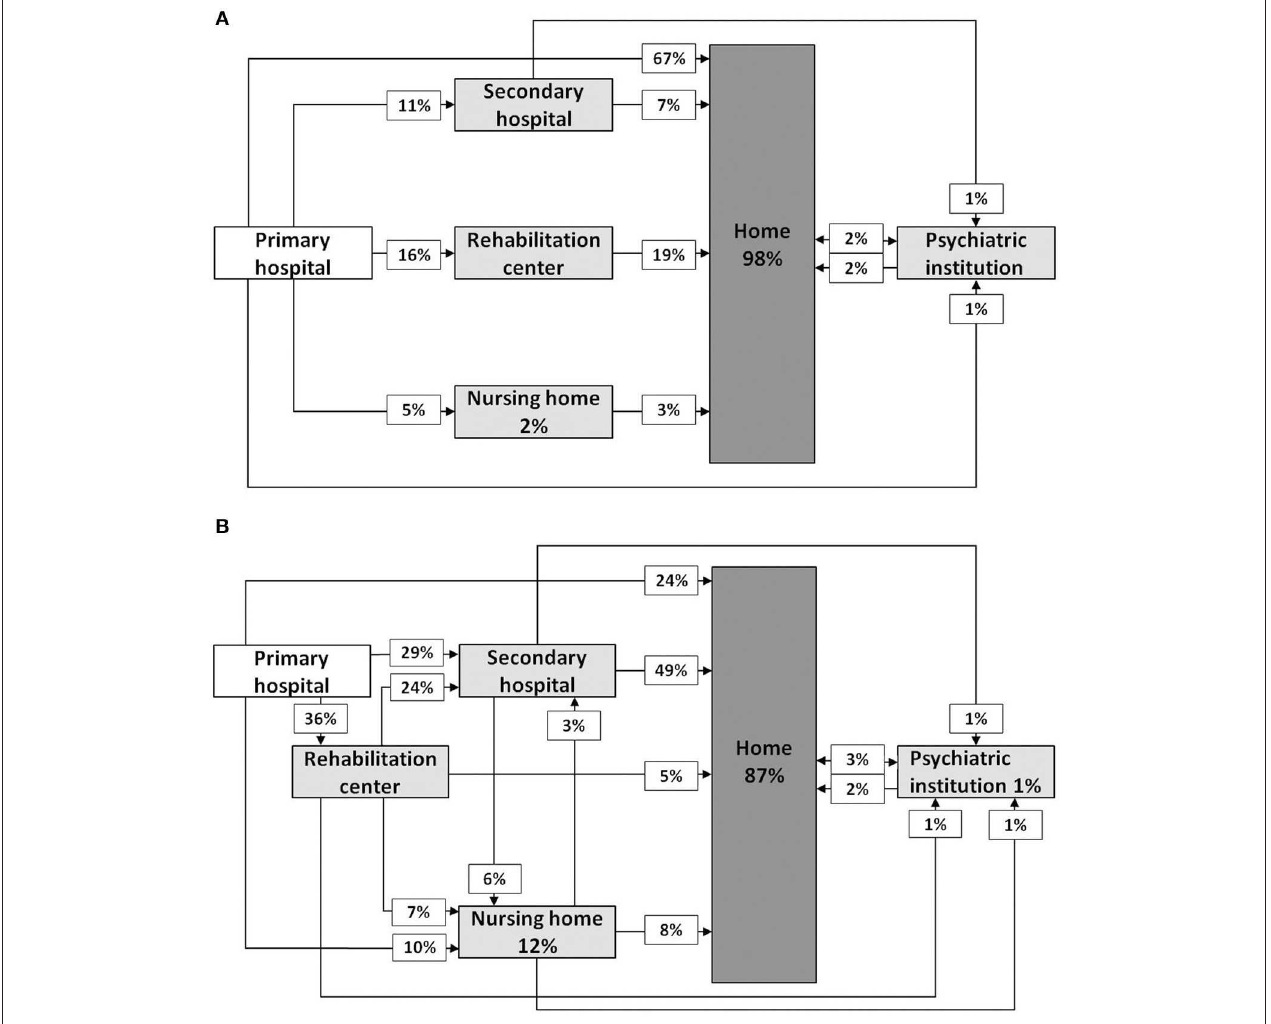
FIGURE 1 | Schedule representing pathways of care after mild TBI (A) and moderate to severe TBI (B) in case of behavioral disturbances. Percentages are rounded to whole numbers.